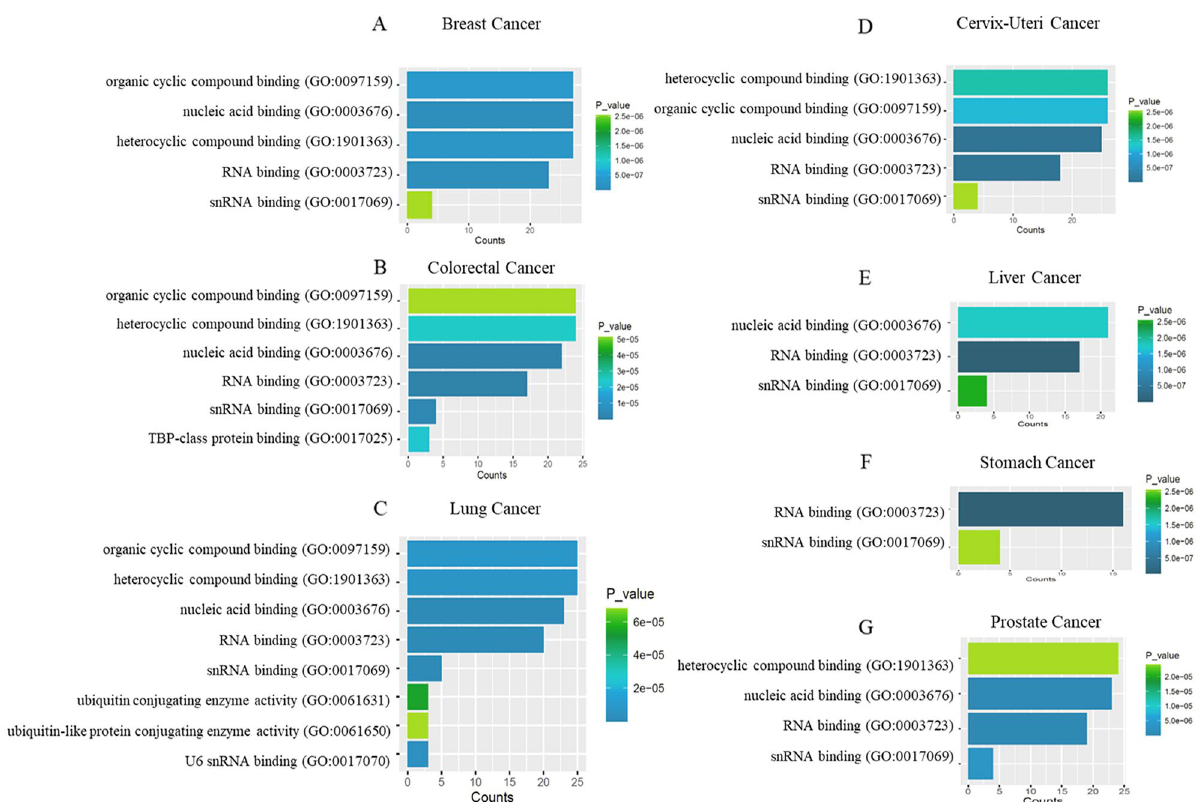
Figure 9. Significantly enriched GO terms for molecular function using FRG1 and correlated genes. ( A ) Breast cancer, ( B ) Colorectal cancer, ( C ) Lung cancer, ( D ) Cervix uteri cancer, ( E ) Liver cancer, ( F ) Stomach cancer, and ( G ) Prostate cancer. The X-axis represents gene counts and Y-axis shows the GO term/molecular